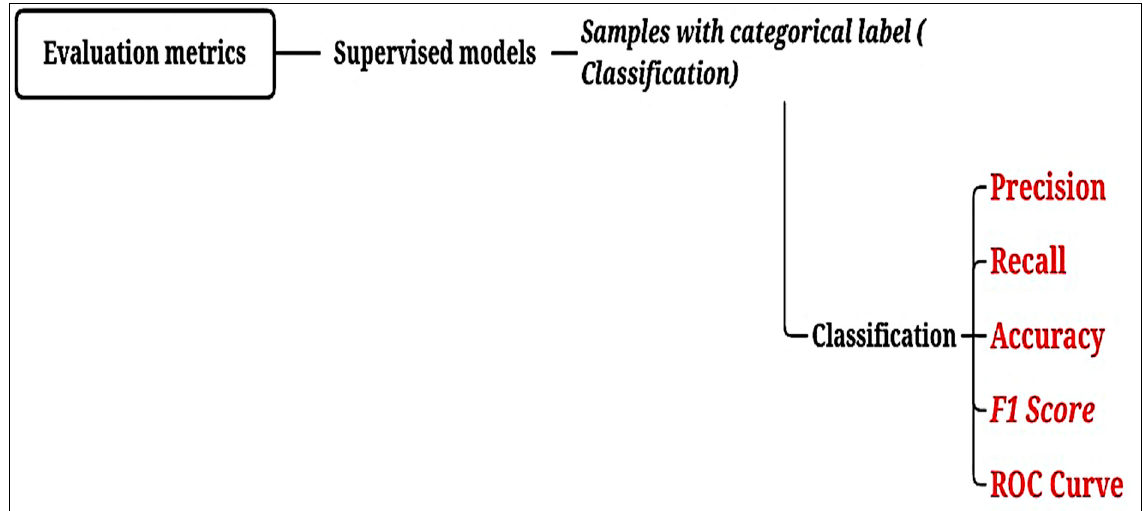
Figure 1. Measures for data